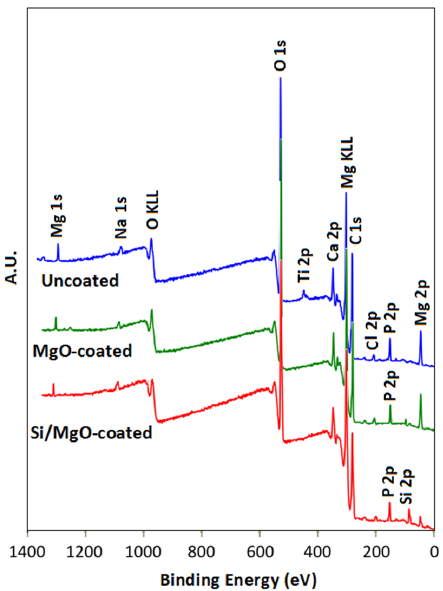
Figure 12. Survey XPS spectra of the uncoated, MgO ‐ coated and Si/MgO ‐ coated after 7 days of immersion in an SBF solution at 37 °C.